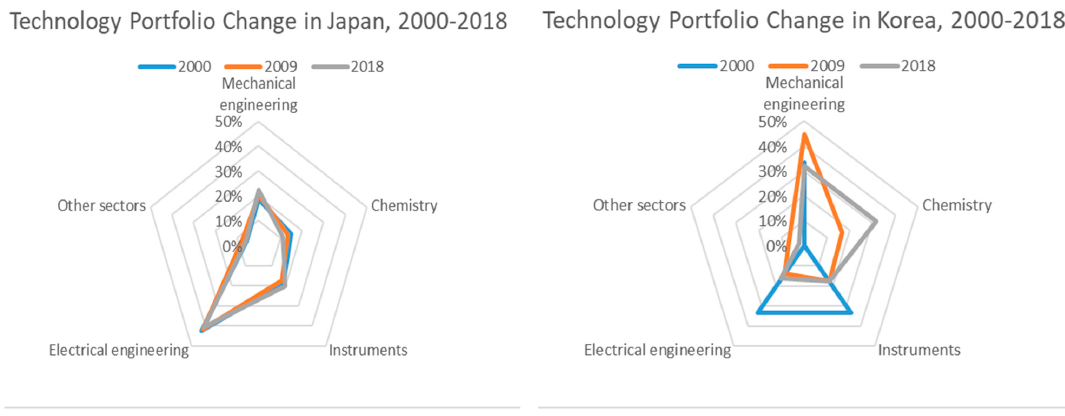
Figure A2. Technology Portfolio Change in Japan and S. Korea, 2000–2018.